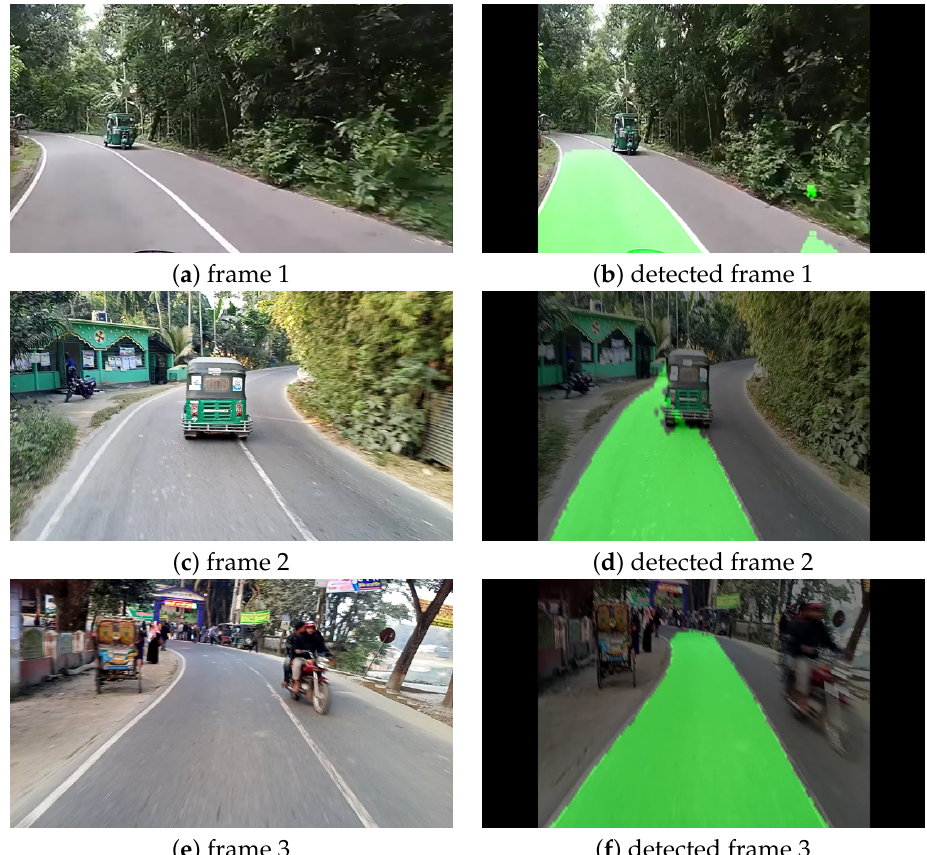
Figure 6. Visualization of lane detection on curvy road